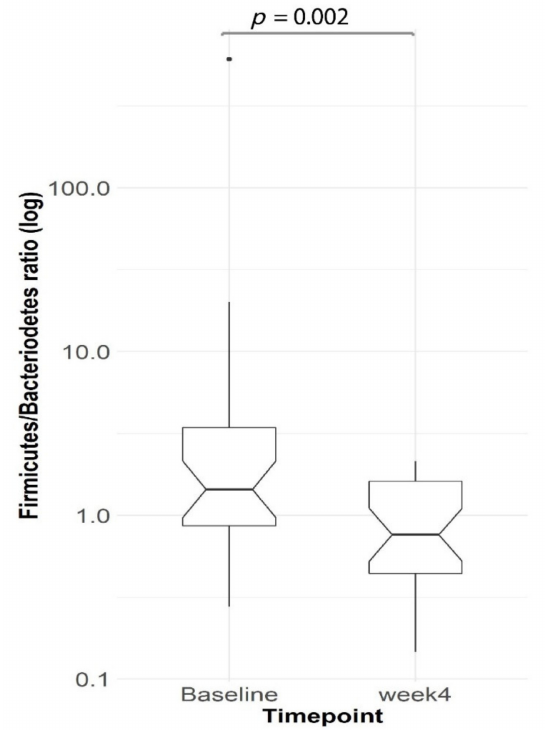
Figure 3. The ratio of Firmicutes / Bacteroidetes phyla decreased (Wilcoxon signed-rank test, p = 0.002, n = 30) from baseline to Week 4 after the VLCD diet. Boxplots as in Figure